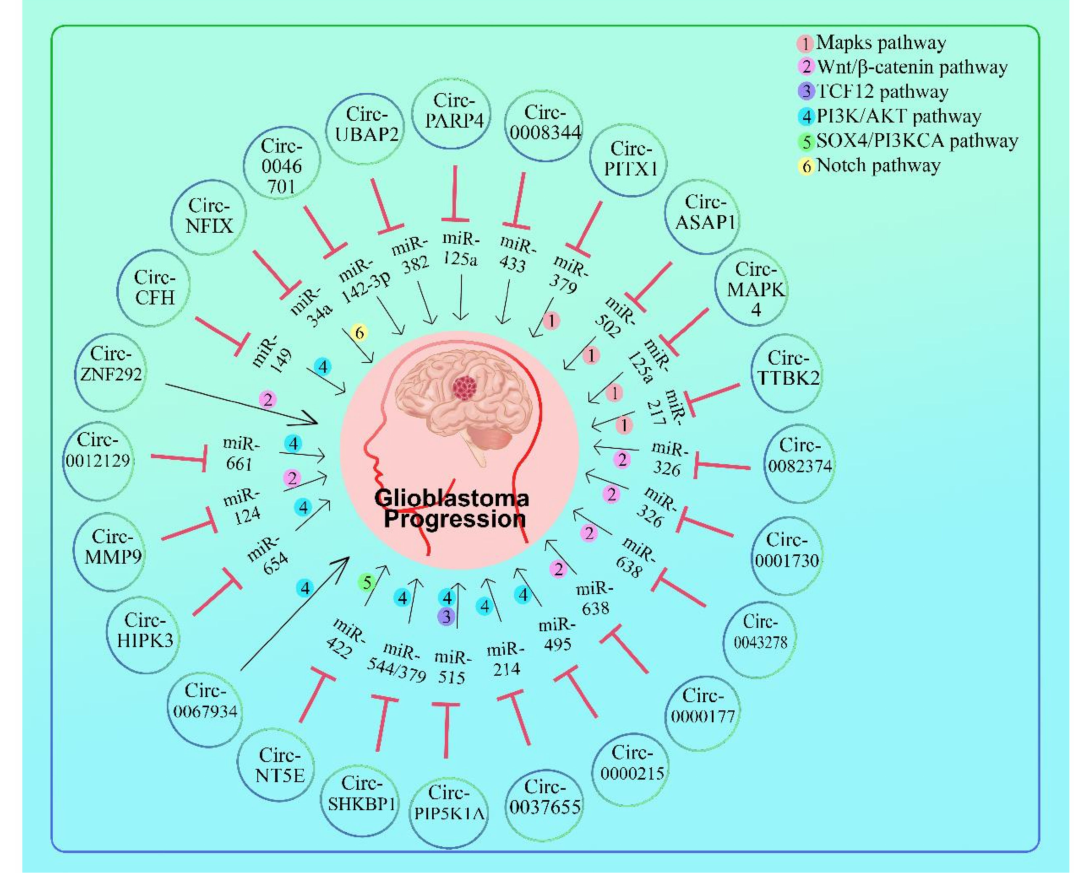
Figure 3. CircRNAs responsible for upregulation of glioblastoma growth: A schematic representation of the circRNAs involved in the regulation of glioma cell proliferation, migration, and invasion, among other functions. Numerous known circRNAs operate as miRNA sponges, subsequently increasing the amount of expression of the appropriate target genes. These target genes or proteins further influence downstream factors involved in cancer signaling pathways by functioning as transcription factors or regulatory proteins, as well as through other mechanisms. CircRNAs such as hsa-circ-0046701, circ- UBAP2, circ-PARP4, Hsa-circ-0008344, circ-PITX1, circ-ASAP1, circ-MAPK4, circ-TTBK2, circ-0082374, circ- 0001730, circ-0043278, circ-0000177, circ-0000215, circ-0037655, circ-PIP5K1A, circ-SHKBP1, circ-NT5E, hsa-circ-0067934, circ-HIPK3, circ-MMP9, hsa-circ-0012129, circ-ZNF292, circ-CFH, and circ-NFIX are responsible for the up-regulation of glioblastoma growth through different pathways including those of the Mapks, Wnt/ β -catenin, TCF12, PI3K/AKT, SOX4/PI3KCA, and Notch. For example, circ-TTBK2 activates the Mapks signaling pathway through